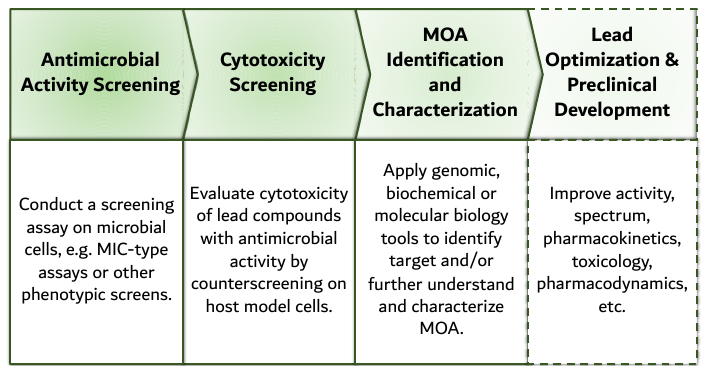
Figure 4. Schematic representation of the cell-based antibiotic discovery platform: drug candidates are identified from cell-based screening assays, a counter-screen excludes cytotoxic compounds, and subsequently genomics tools are applied to identify MOA. Although MOA is not a requisite, it may facilitate lead optimization and preclinical development, for instance, structural information on the target can enable a rational modification of the drug candidate.